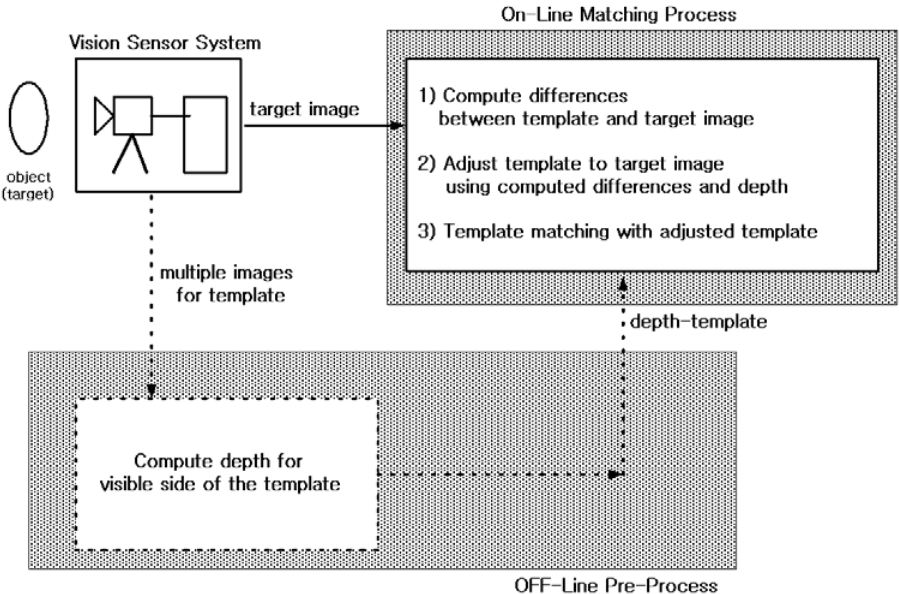
Figure 1. Proposed template matching vision system.